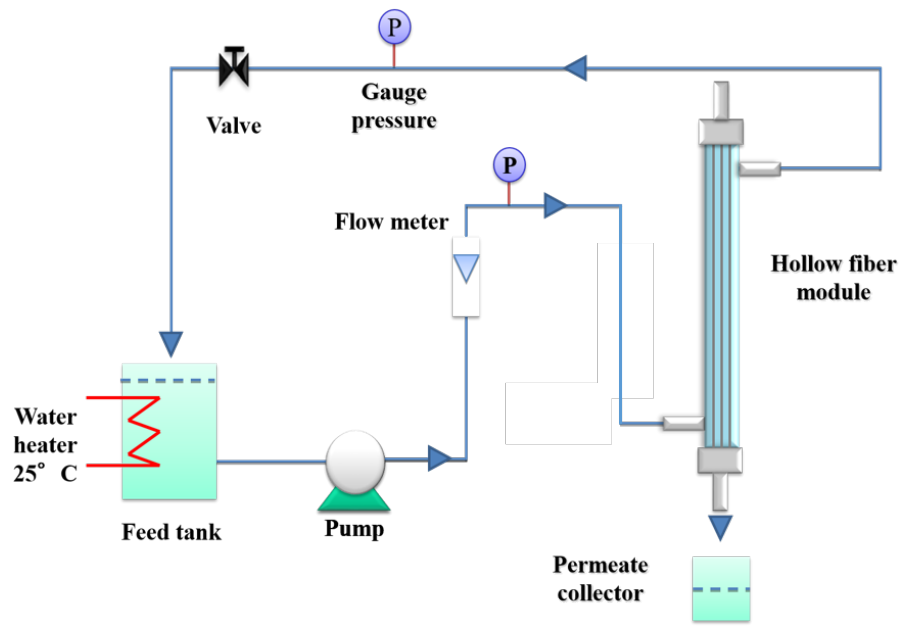
Figure 1. Scheme of the setup used for the pure water permeability (PWP) measurements.